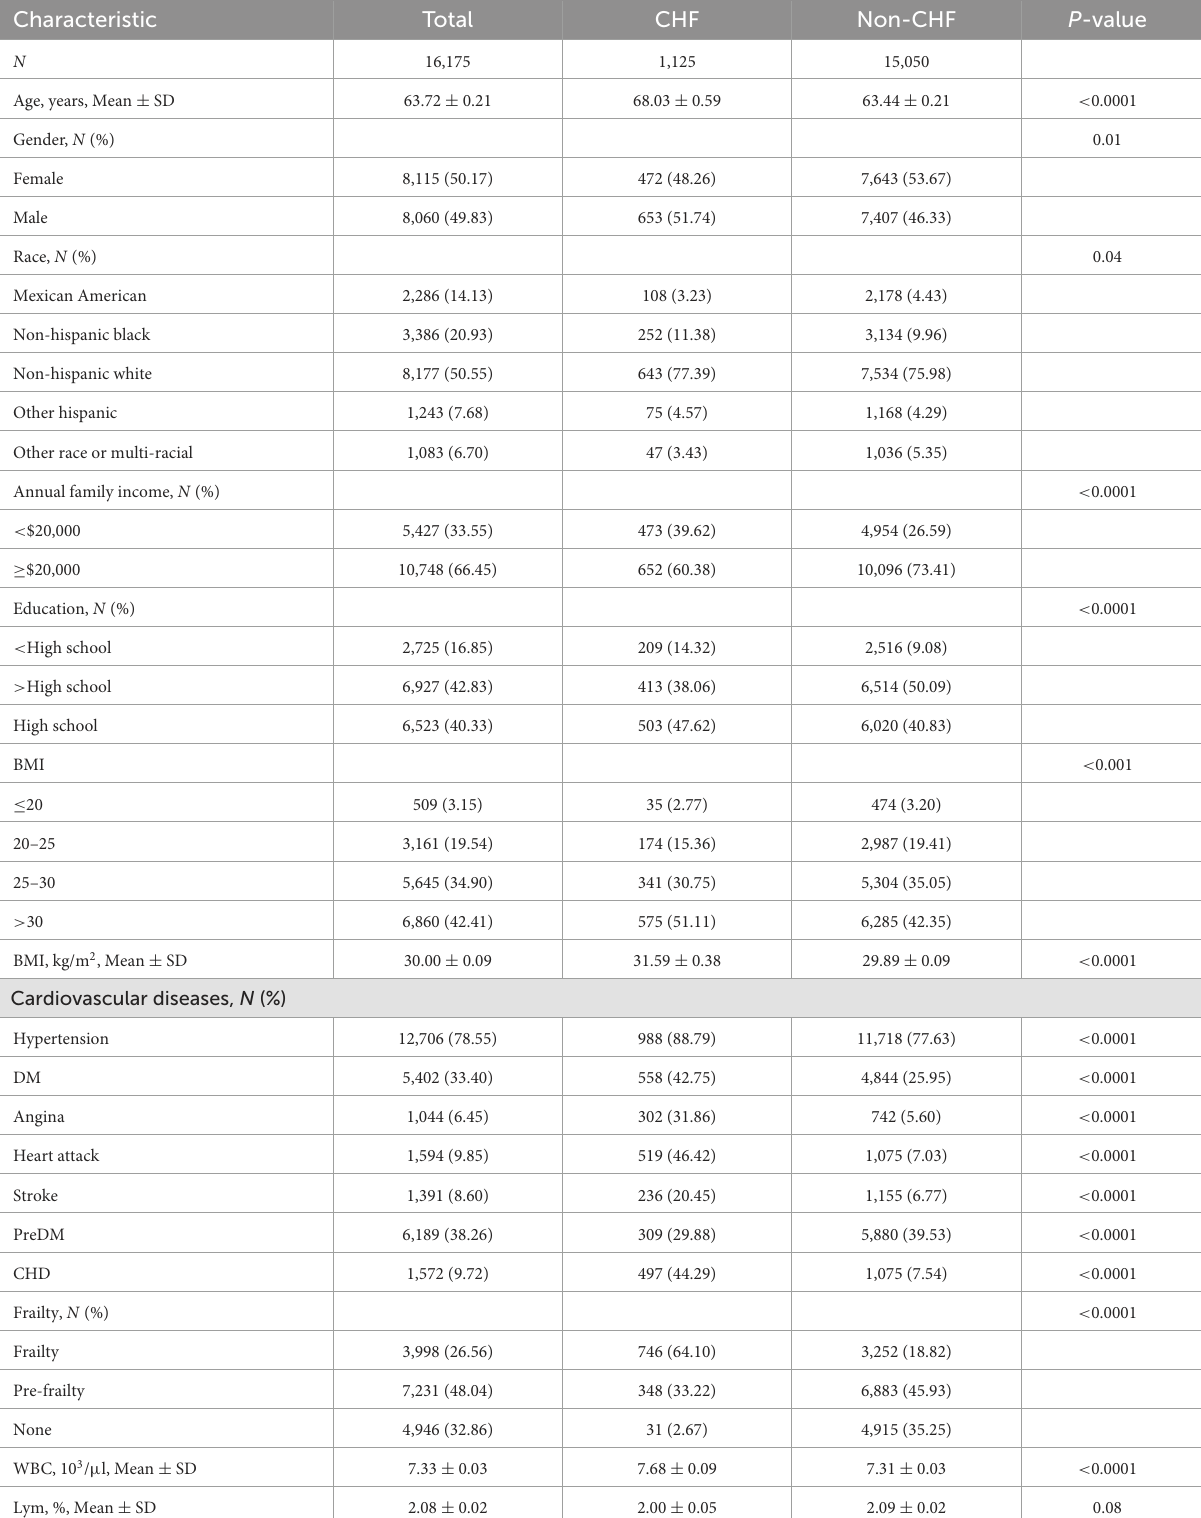
TABLE 1 Characteristics of participants with and without CHF.